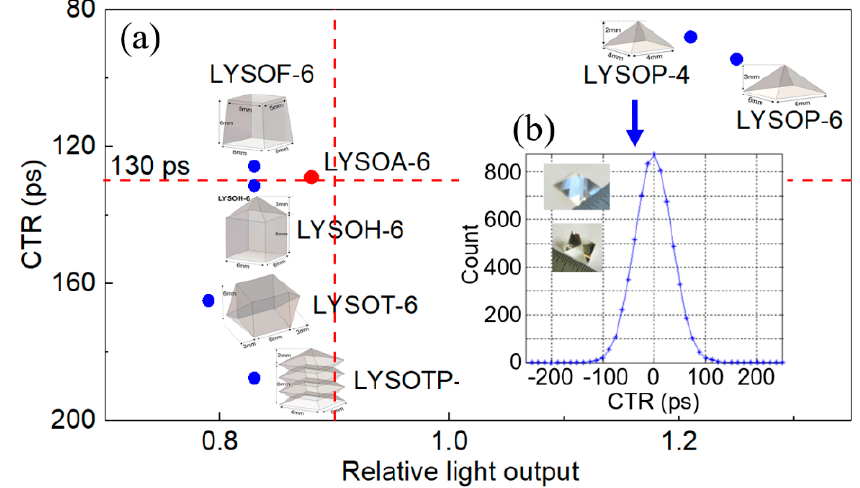
Figure 11. ( a ) CTR and the relative light output of six types of odd crystals (blue points); ( b ) time spectrum of LYSOP-4.